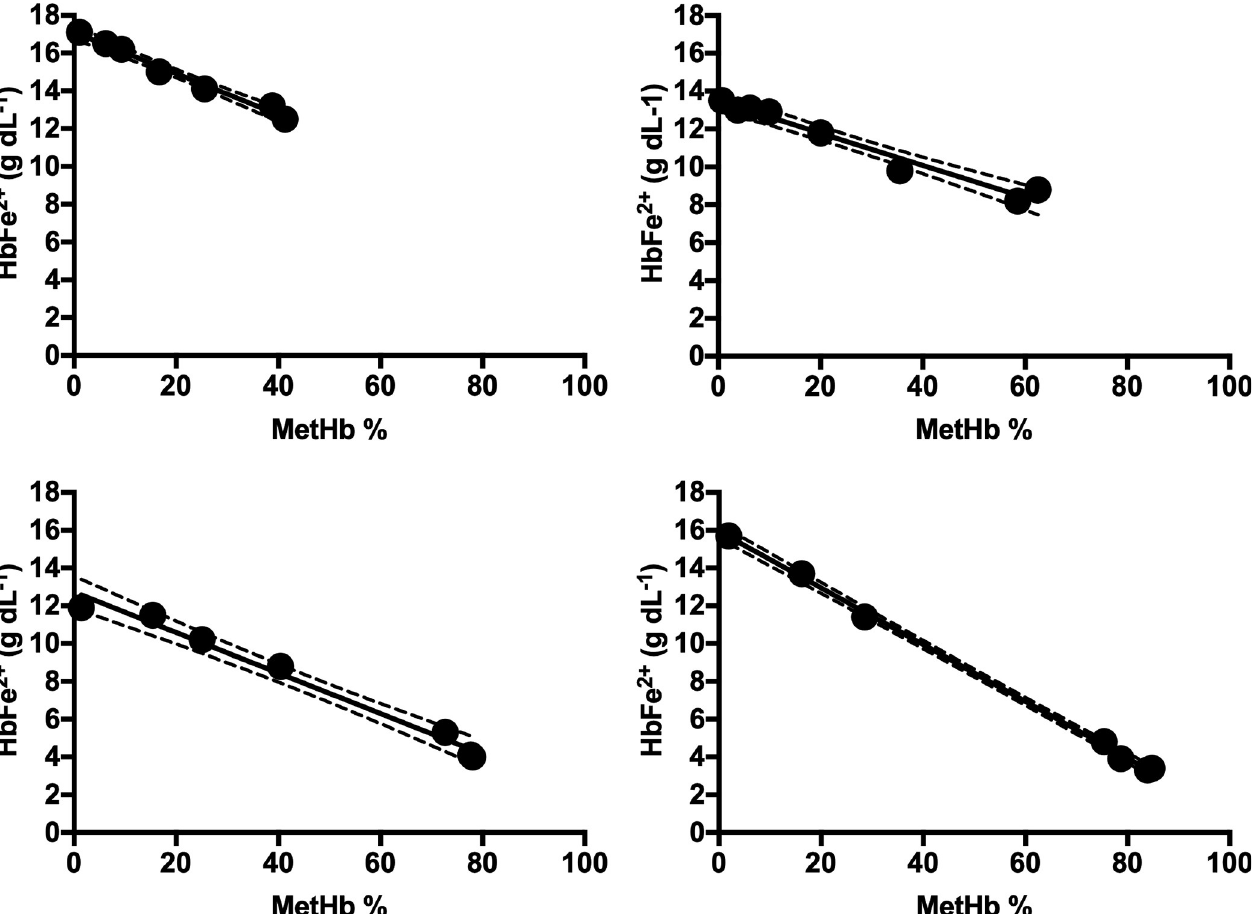
Fig 3. Haemoglobin (HbFe 2+ g dL -1 ) derived from Cera-Chek regressed with methaemoglobin (MetHb %) determined by the Avoximeter 4000 CO-Oximeter using whole blood aliquots incubated with an in vitro gradient of 0, 2.5, 5, 10, 15, 20, 40 mmol L -1 NaNO 2 for (a) chicken, (b) possum, (c) cat and (d) dog blood. https://doi.org/10.1371/journal.pone.0282820.g003 PLOS ONE | https://doi.org/10.1371/journal.pone.0282820 March 16,